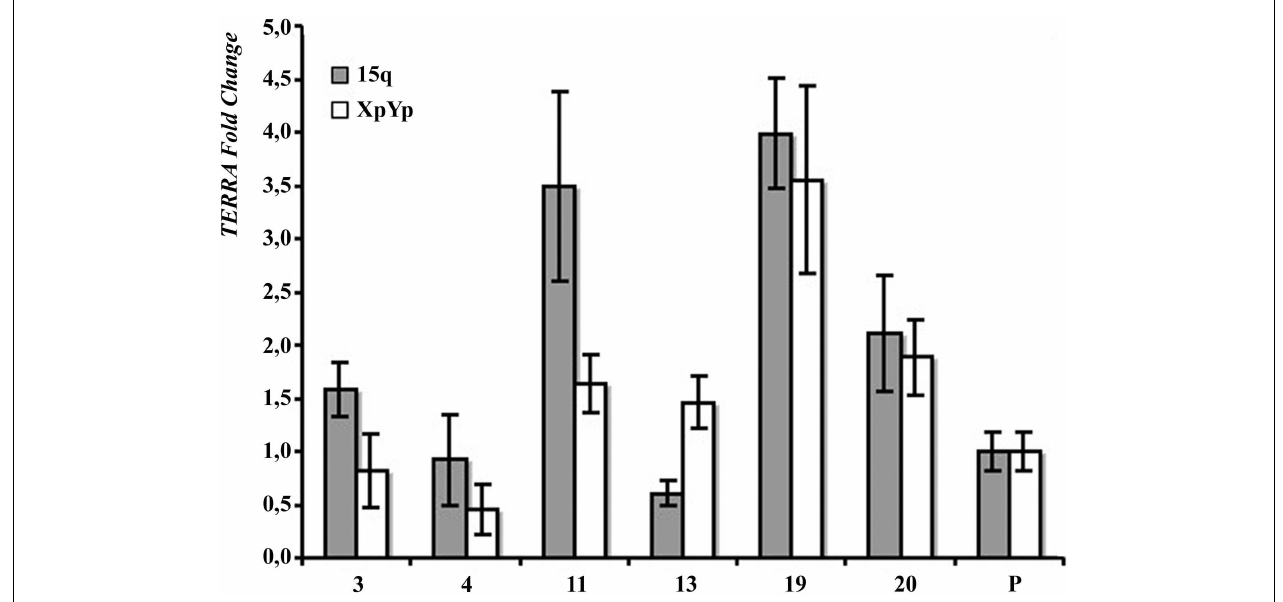
FIGURE 3 | Subtelomere-specificTERRA levels in HeLa parental line (P) and six clones, determined by qRT-PCR on 15q (gray bars) and XpYp (white bars) subtelomeres .The values of HeLa parental line is arbitrarily set at 1. Average values from three independent reactions are shown.